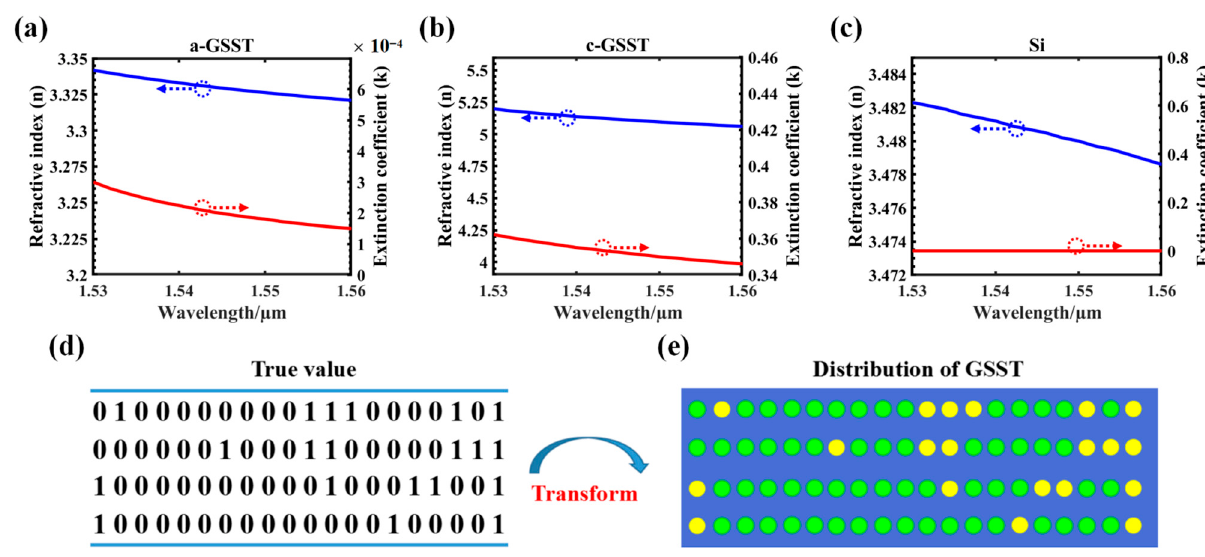
Figure 2. ( a – c ) Refractive indices, n, and the extinction coefficients, k, of a-GSST, c-GSST, and silicon from 1530 to 1560 nm; ( d , e ) GSST distribution corresponding to the true value.